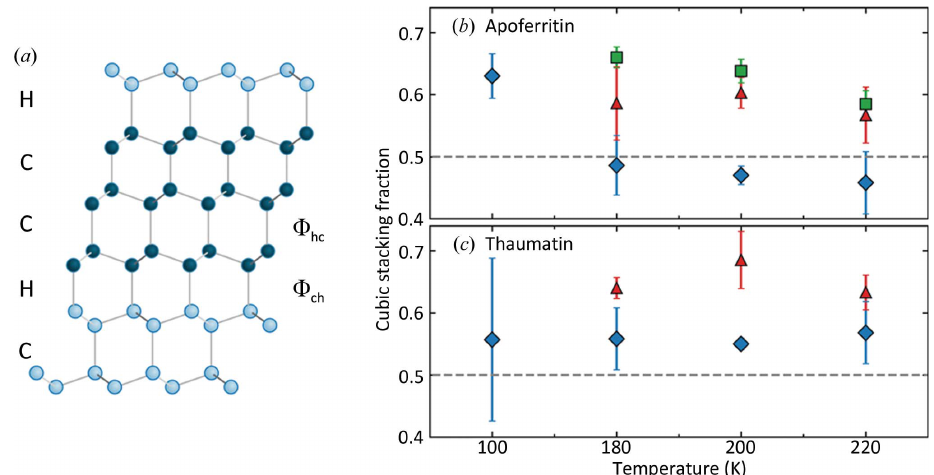
Figure 7 ( a ) Model of stacking-disordered ice (I sd ; adapted from Malkin et al. , 2012) showing O atoms connected by hydrogen bonds. Along the vertical direction [normal to the (001) planes in I h and to the (111) planes in I c ], successive cubic ice planes are horizontally shifted, whereas successive hexagonal planes are mirror- reflected about a horizontal axis. On the left, C and H indicate pairs of planes that have cubic and hexagonal stacking, respectively. On the right, (cid:3) ch indicates the probability that a cubic stacking is followed by hexagonal stacking, and (cid:3) hc indicates the probability that a hexagonal stacking is followed by cubic stacking. ( b , c ) Cubic stacking fraction (cid:3) hc /( (cid:3) hc + (cid:3) ch ) versus temperature for ( b ) apoferritin and ( c ) thaumatin crystals, determined from DIFFaX fits as in Figs. 6( e ) and 6( f ). The symbols indicate samples with different glycerol concentrations as in Fig.